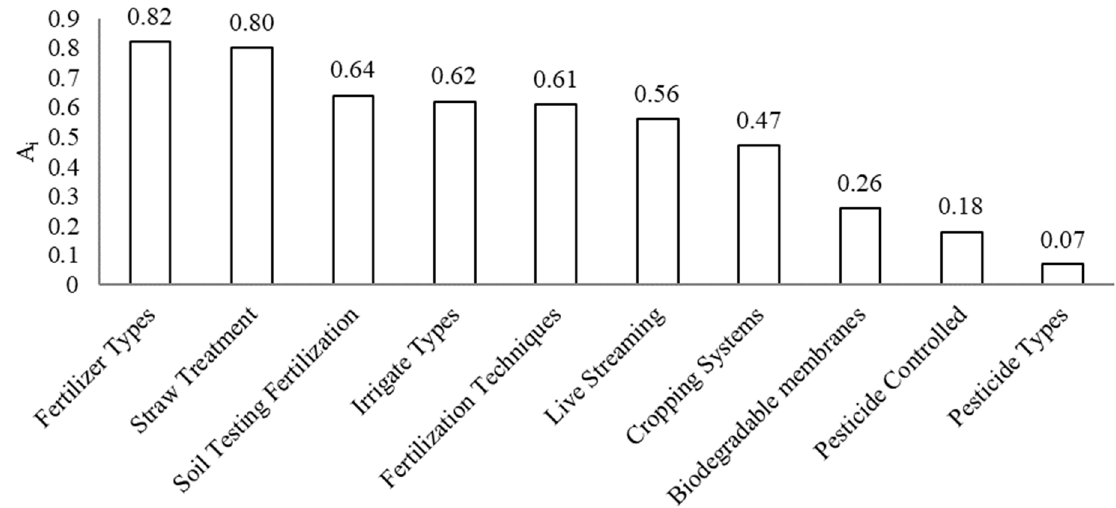
Figure 3. Average status of low-carbon technology applications in agriculture.